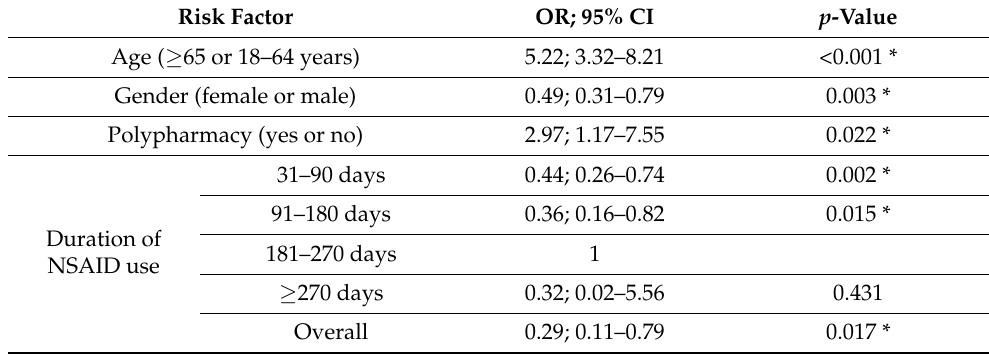
Table 3. Association between risk factors and patients with at least one positive prescribing safety indicator (data obtained from logistic regression